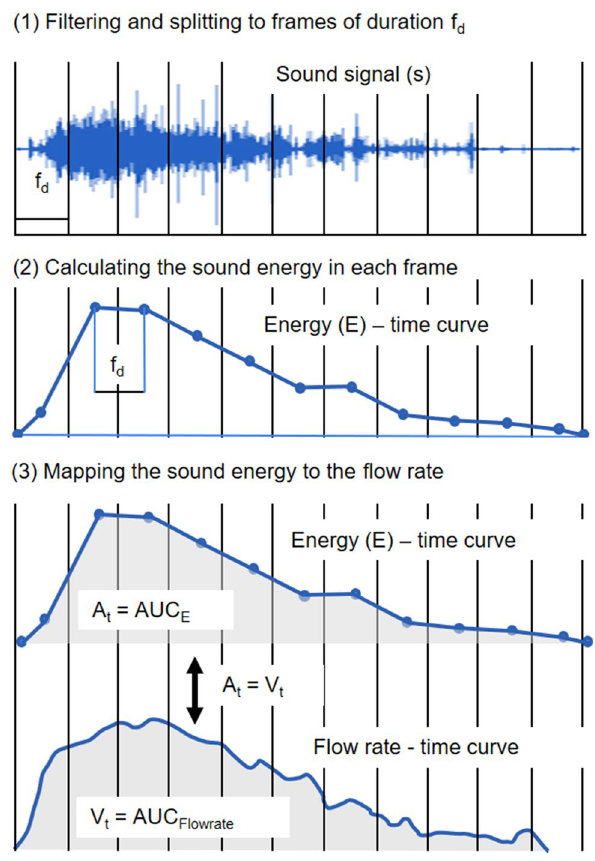
Figure 2. Transforming the sound signal to a flow rate-time curve. (1) The sound signal is split into frames of duration f d . (2) The energy is calculated for each frame and the energy-time curve is generated. This energy varies in conjunction with the flow rate and can be transformed into a flow rate curve. (3) The energy-time curve is linearly mapped to the flowrate-time curve by equating A t , the area under the energy curve (AUC E ), to the total voided volume V t which corresponds to the area under the flowrate curve (AUC Flowrate ).